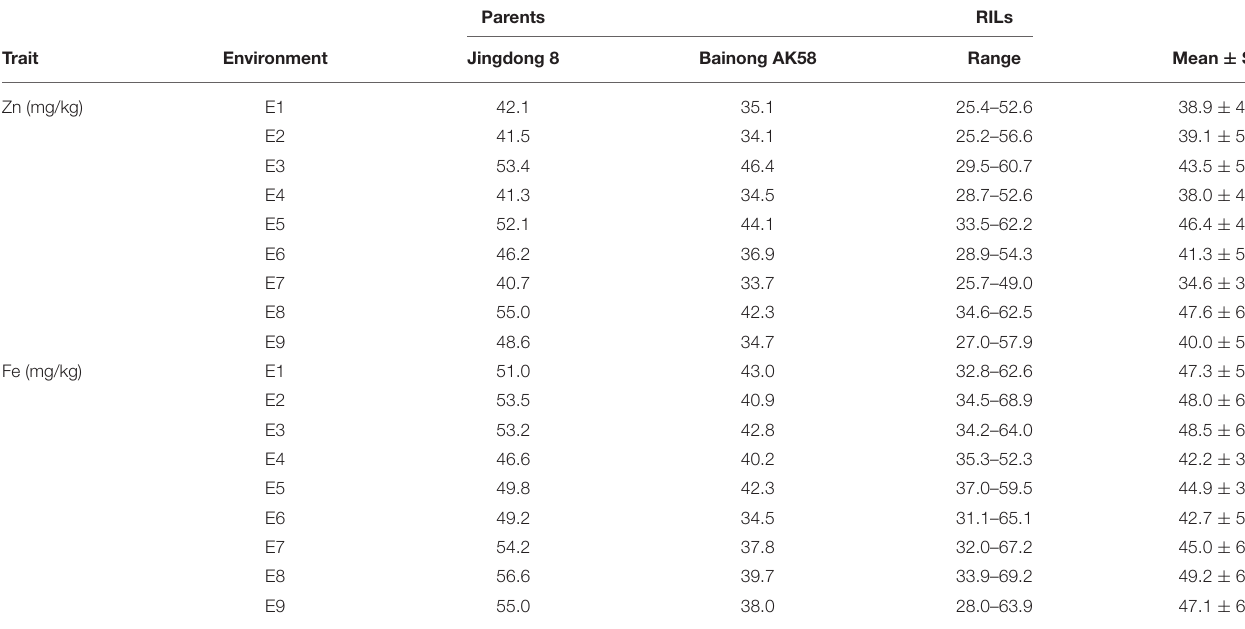
TABLE 2 | Mean and range of GZn and GFe (mg/kg) in the Jingdong 8/Bainong AK58 RIL population among nine environments.